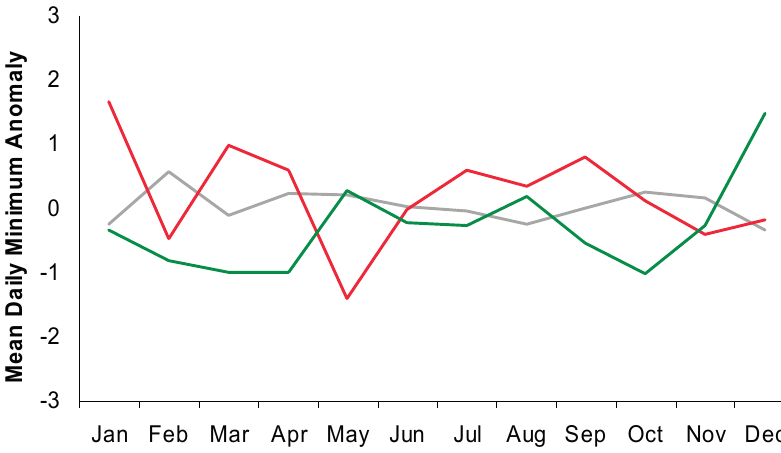
Figure 7. Monthly values for mean 7-day anomalies of minimum daily temperatures for high-end (red), low-end (green), and all other (gray) suicide weeks in Jackson, Mississippi.